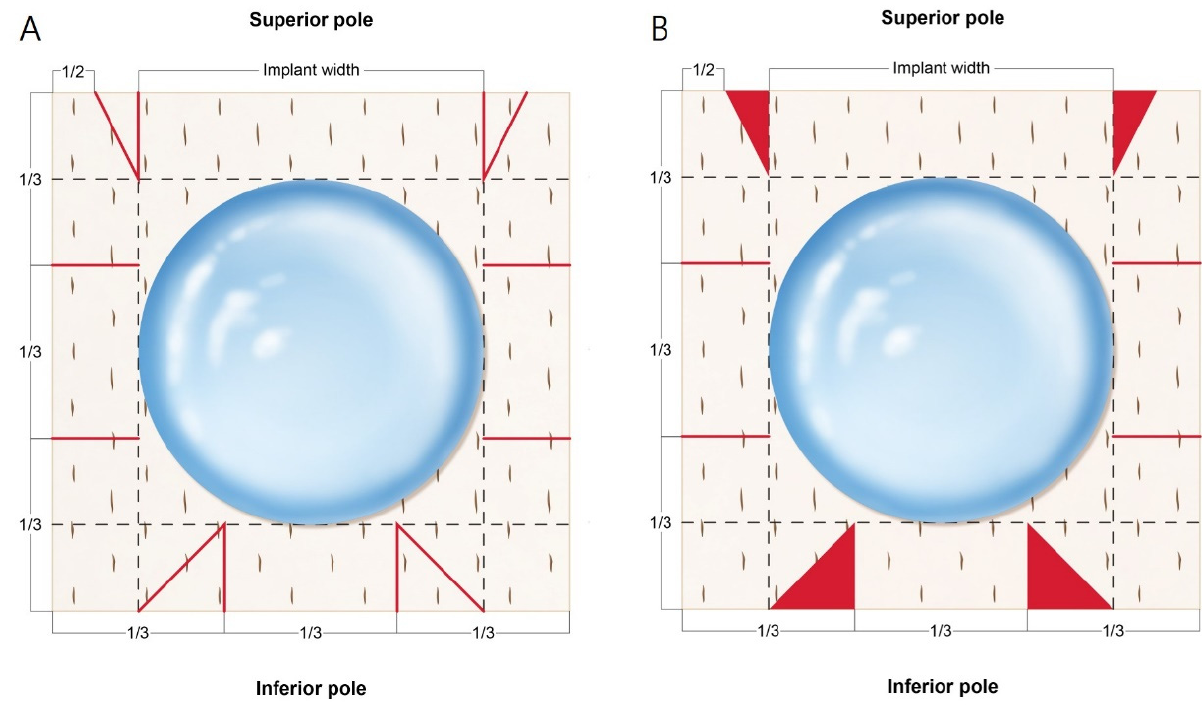
Figure 1. ”Tear ‐ drop appearance” wrapping technique design for breast implant. ( A ) The sides and inferior poles were divided into thirds. The dotted line indicates the implant width and the red solid line indicates the part cut with the no. 15 surgical scalpel blade. ( B ) This is a template of the implant placed after cutting. The cut triangular part (red) is retained.